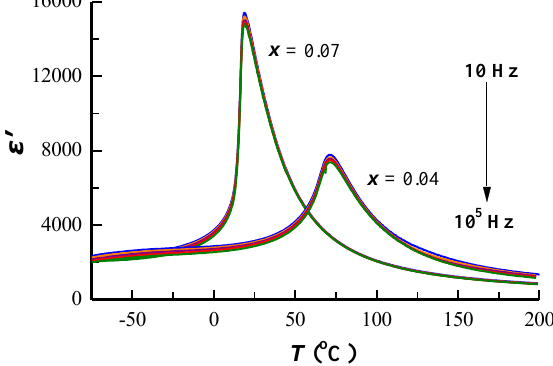
Figure 4. Temperature dependence of dielectric permittivity for samples with x = 0.04 and 0.07 at various frequencies.